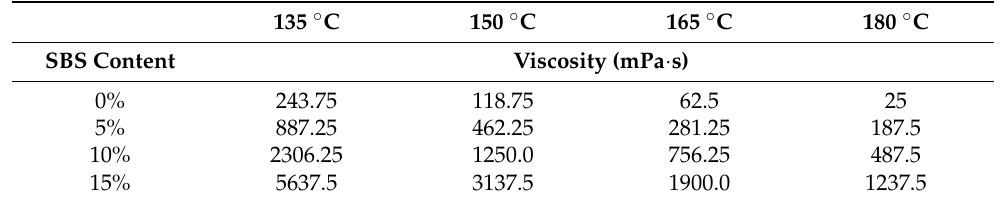
Table 5. Viscosity values for PG 64-22 with 12% processed oil as a function of the SBS content and temperature.